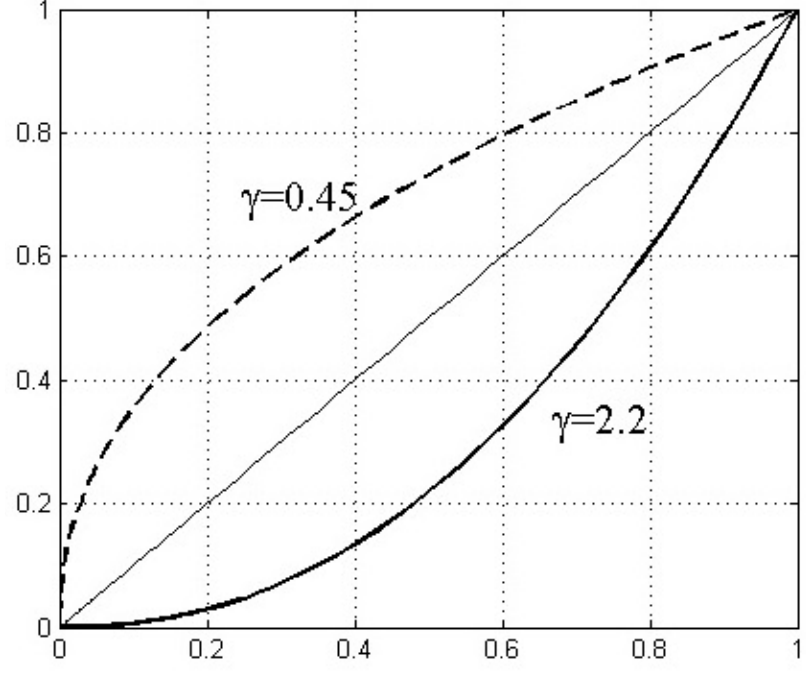
Figure 1. Gamma correction curves with various γ